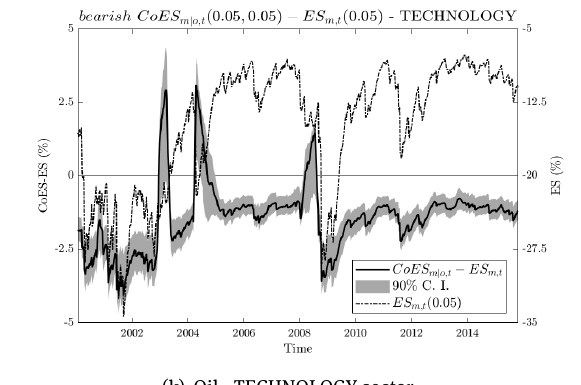
(k) Oil - TECHNOLOGY